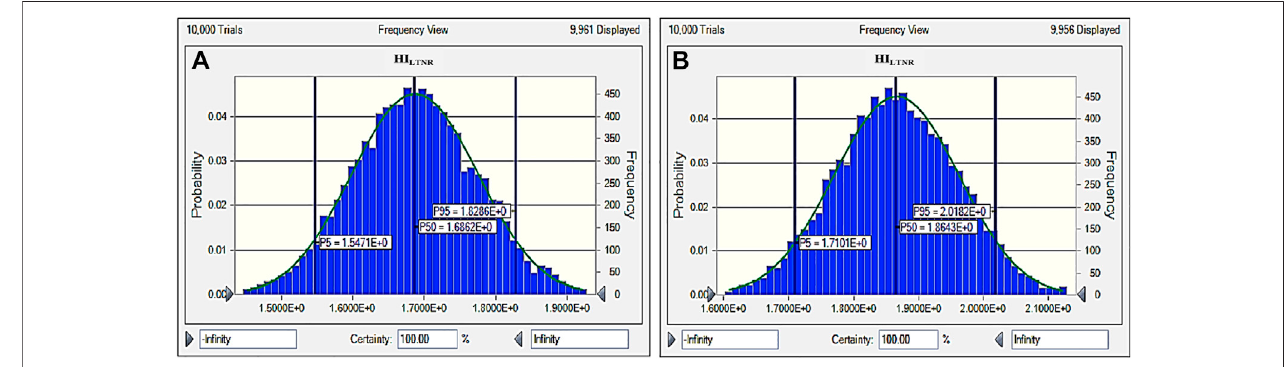
FIGURE 6 | Probabilistic health risk assessment of fl uoride for lifetime exposure (HI LTNR ) for percentile doses from P5 to P95 in (A) Bankura and (B) Purulia.